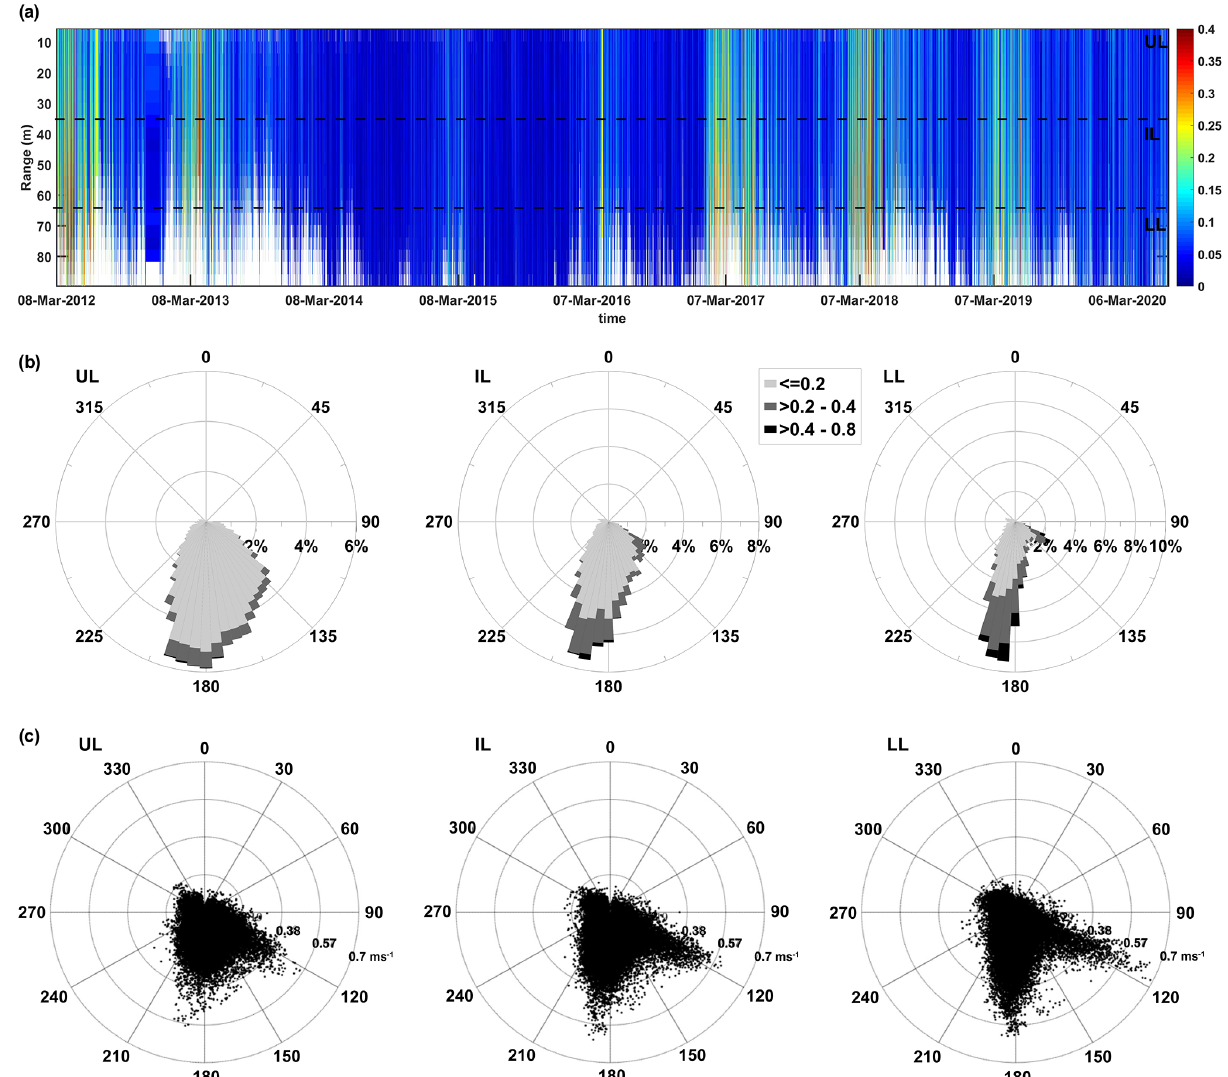
Figure 8. (a) Currents’ speed records along the water column (data represented are filtered by 80% percent good), dotted box indicates the water column corresponding to the three layers used for polar plot representation. (b) Polar probability plot of current velocity in the three layers of the water column (ms − 1 ). (c) Polar scatterplot of observed directional current velocity (ms − 1 ) (UL: upper layer; IL: intermediate layer; LL: lower layer) –